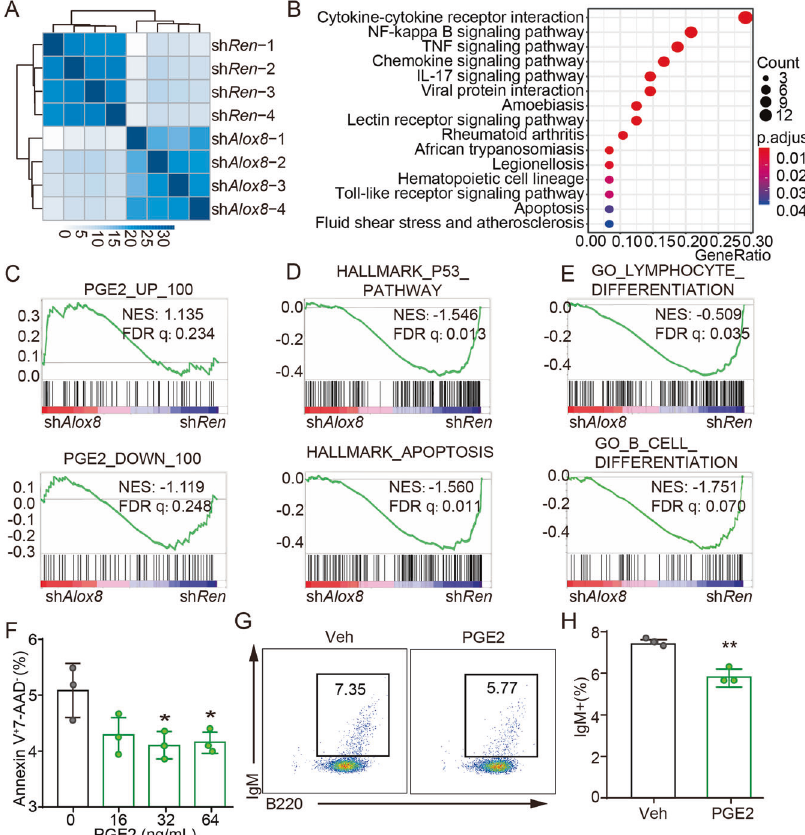
Fig. 2 Transcriptome analysis revealed that inhibition of Alox8 has similar gene expression as PGE2-treated cells. A Unsupervised clustering of RNA-seq data of sh Alox8 or sh Ren pre-B cells. n = 4, B KEGG enrichment analysis of genes downregulated in sh Alox8 cells comparing to sh Ren cells. C – E Gene set enrichment analysis of genes belonging to the top 100 differentially expressed genes with PGE2 treatment ( C ), HALLMARK_P53_PATHWAY and HALLMARK_APOPTOSIS gene sets ( D ) or GO_LYMPHOCYTE_DIFFERENTIATION and GO_B_CELL_DIFFERENTIATION gene sets ( E ) in sh Alox8 cells comparing to sh Ren cells. NES, normalized enrichment score; FDR, false discovery rate. F The percentage of Annexin V + 7-AAD- apoptotic cells of pre-B cells treated with different concentrations of PGE2, measured by fl ow cytometry. n = 3. * p < 0.05 (unpaired two-tailed t -test). G , H The percentage of IgM + in B220 + B cells as measured by fl ow cytometry analysis. n = 3. Error bar represents “ Mean with SEM ” , ** p < 0.01(unpaired two-tailed t